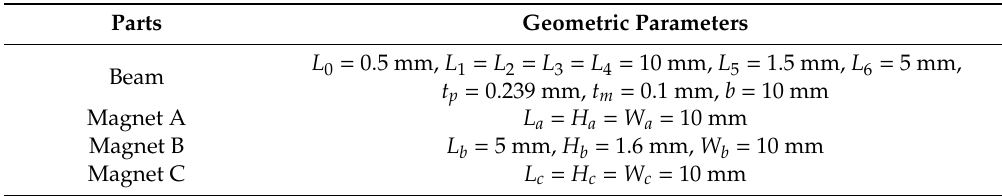
Table 1. The geometric parameters of the beam and magnets.